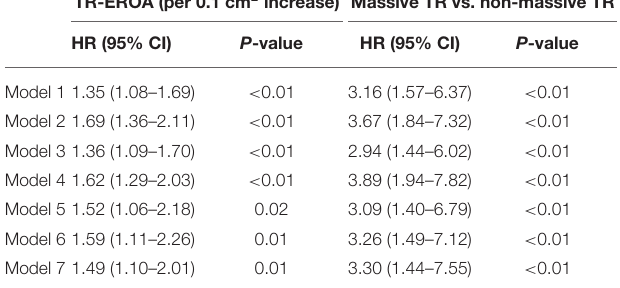
TABLE 3 | Prognostic value of TR